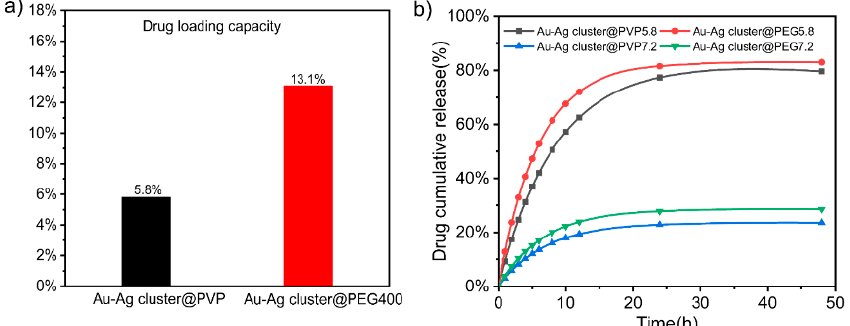
Figure 6. ( a ) Drug loading capacity of Au-Ag cluster @PVP and Au-Ag cluster@PEG400, respectively; ( b ) Time-dependent of DOX releasing profiles of Au-Ag cluster @PVP-DOX and Au-Ag cluster @PEG400-DOX at pH = 5.8 and 7.2, respectively.